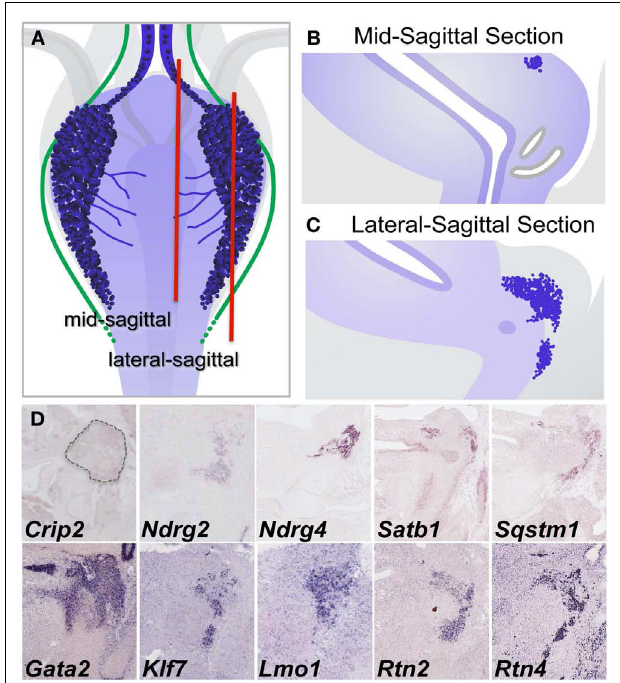
FIGURE 8 |Validation of gene expression patterns in pelvic ganglia by sectional in situ hybridization (SISH). (A) Schematic diagram of 15.5dpc fetal mouse LUT viewed dorsally illustrates pelvic ganglia (dark blue clusters), neurites extending from pelvic ganglia across the dorsal urethral surface (blue lines), and axonal processes (green lines) relative to LUT structures. Red vertical lines indicate the relative planes of cryosections taken through mid-sagittal (B) and lateral sagittal regions (C) for SISH processing. Colorometric micrographs of SISH signals obtained in cryosections for individual genes (D) . Images for Crip2 , Ndrg4 , Satb1 , and Sqstm1 are from data deposited at the GUDMAP database (probe IDs: MGI:3507380, MGI:3506573, MGI:3506384, MGI:3506375, respectively). Images for Ndrg2, Gata2 , Klf7 , Lmo1 , Rtn2 , and Rtn4 derive from data posted on Eurexpress.org (probe IDs: euxassay_010581, section 14; euxassay_018037, section 14; euxassay_003485, section 16; euxassay_017874, section 07; euxassay_018264, section 14; and euxassay_004344, section 14, respectively). Dotted line outlines the pelvic ganglia border in SISH panel for Crip2 as the expression for this gene is not homogeneous within cells but was observed as faint punctate signal within some cells and not in